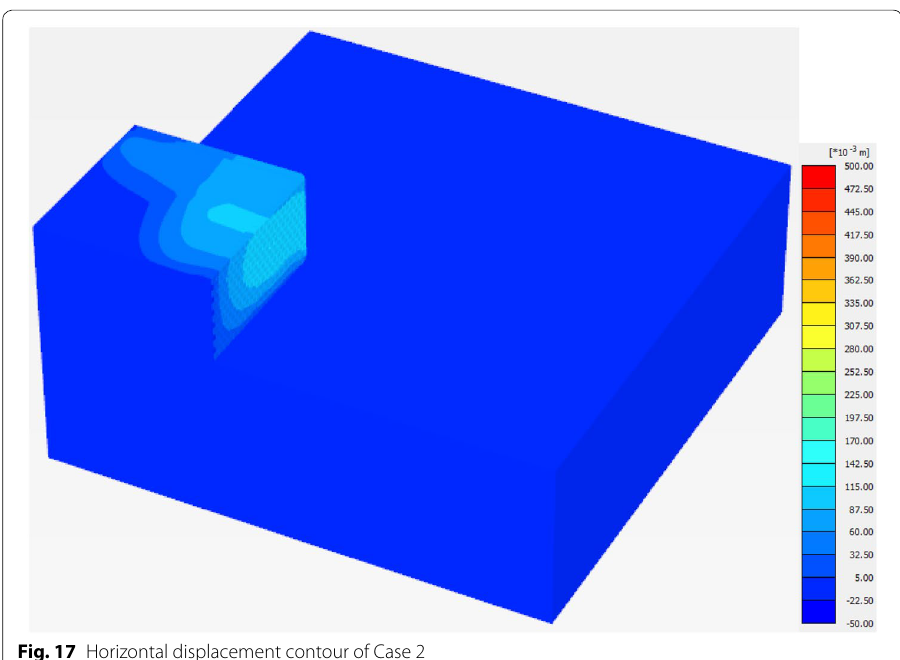
Fig. 17 Horizontal displacement contour of Case 2